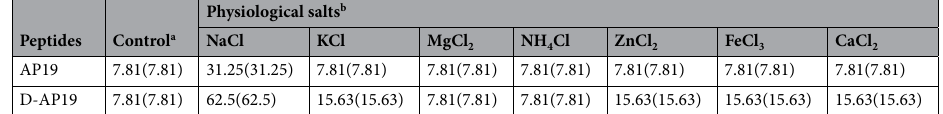
Table 5. The antimicrobial activity (MIC and MBC) (µg/ml) of AP19 and D-AP19 against A. baumannii ATCC 19,606 in the presence of serum salts at physiological concentrations. a Control MIC was evaluated in the absence of serum salts. b The final concentrations of NaCl, KCl, MgCl 2 , NH 4 Cl, ZnCl 2 , FeCl 3 , and CaCl 2 were 150 mM, 4.5 mM, 1 mM, 6 µM, 8 µM, 4 µM and 2.5 µM, respectively.